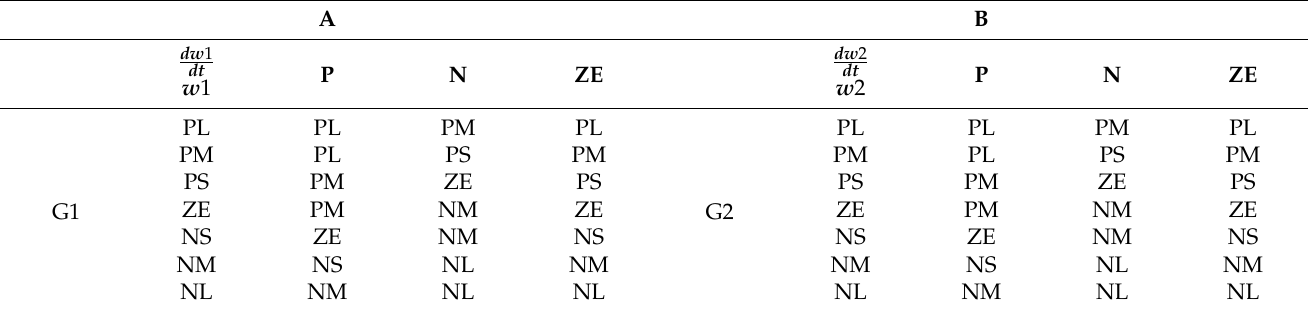
Figure 7. Inputs and output membership functions: ( a ) Angular velocity of generators, ( b ) variations of angular velocity of generators, ( c ) output of fuzzy controller. NL, negative large; NM, negative medium; Z, zero; PM, positive medium; PL, positive large; N, negative; P, positive. Table 1. Fuzzy rules according to fuzzy system inputs and output (a) G1 and (b)